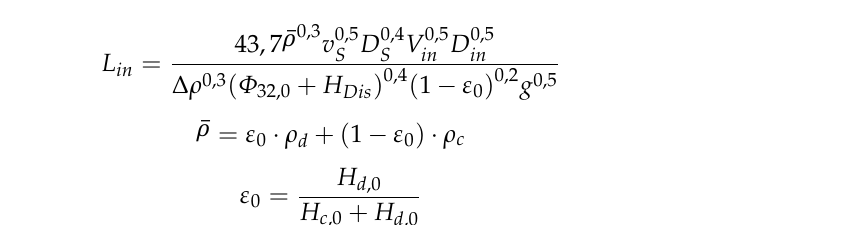
Table 1. Yield, purity, and cell reduction of the investigated ATPS.